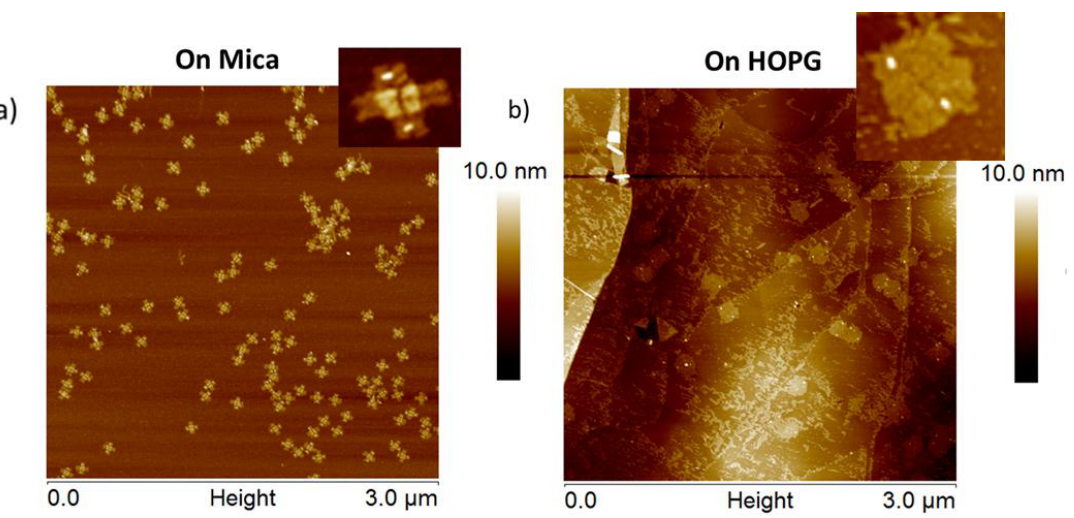
Figure 8. AFM images of cDO modified with streptavidin, on ( a ) mica and on ( b ) HOPG.